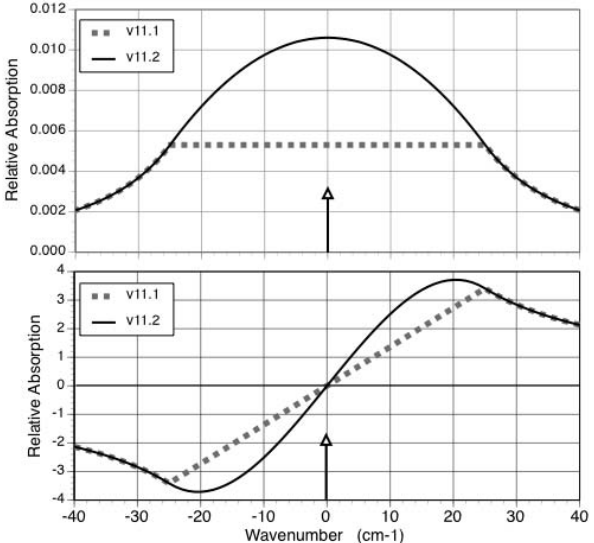
Fig. 13. The top panel represents the function associated with the Lorentz contribution to the continuum. The old system (v11.1) has a pedestal from − 25 to 25cm − 1 ; the new function is quadratic in the same domain. The lower panel shows the line coupling contri- bution over the same region. The discontinuities in the slope associ- ated with v11.1 lead to discontinuities in the continuum, which are averted by using the continuous functions of v11.2.